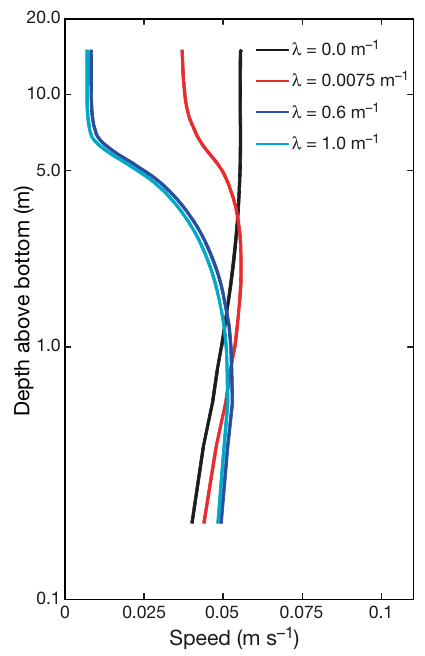
Fig. 8. Vertical distributions of tidal cycle averaged speeds with different cage drags ( λ with further increases in the drag coefficient. Sedi-